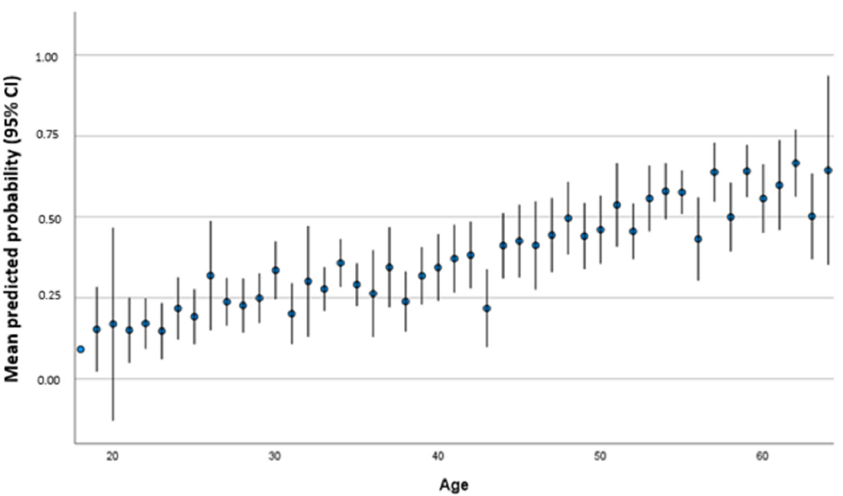
Figure 3. Mean predicted probability (95% CI) to achieve a threshold below 54 IU/mL according to age in years.